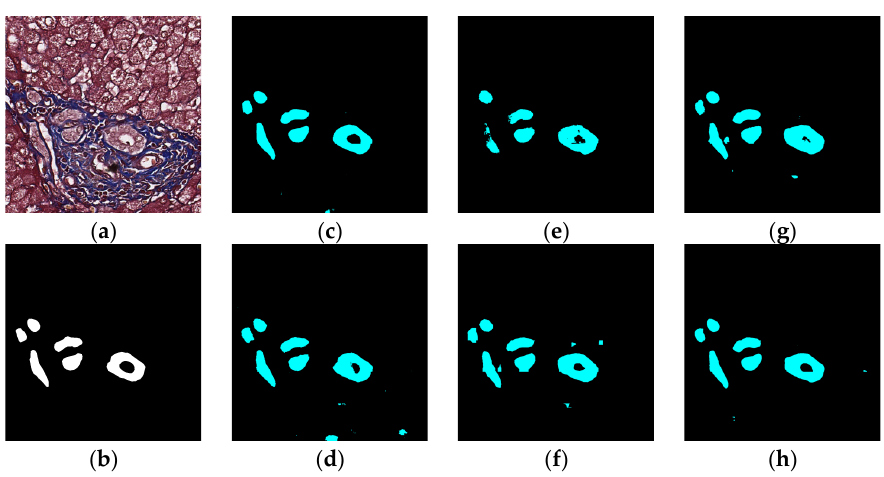
Figure 7. Segmentation results for clearly visible bile ducts: original ( a ), GT ( b ), FCN ( c ), SegNet ( d ), U ‐ Net ( e ), Deeplabv3 ( f ), Deeplabv3 ‐ plus ( g ), and the proposed network ( h ).